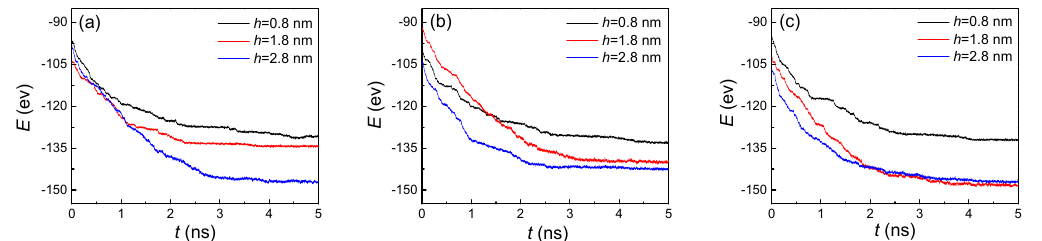
Figure 5. The potential energy between argon atoms and the cold wall with three groove heights and widths of ( a ) 1.8, ( b ) 2.4, and ( c ) 3.2 nm on hydrophilic surfaces.